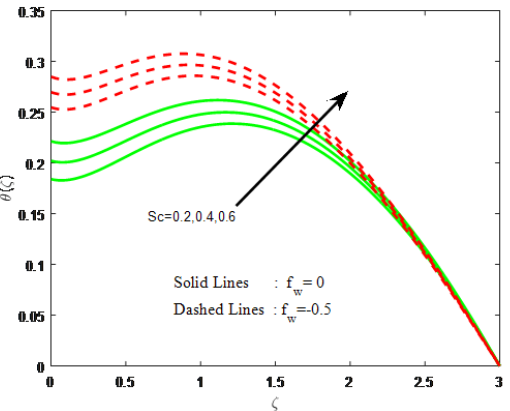
Fig. 17: The effect of Schmidt number ( Sc ) on temperature